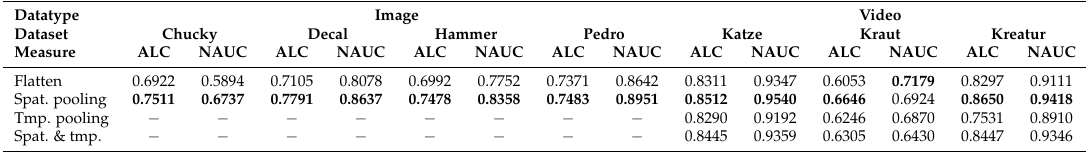
Table 3. Vision: Comparison of different pooling methods for image and video classification, using the MobileNetv2 architecture.